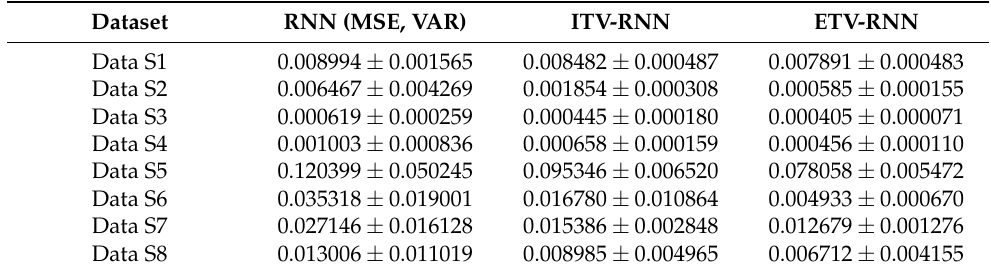
Table 2. Predictive performance of RNN, ITV-RNN, and ETV-RNN on different simulated datasets. The average MSE and variance were obtained using five-fold cross-validation.